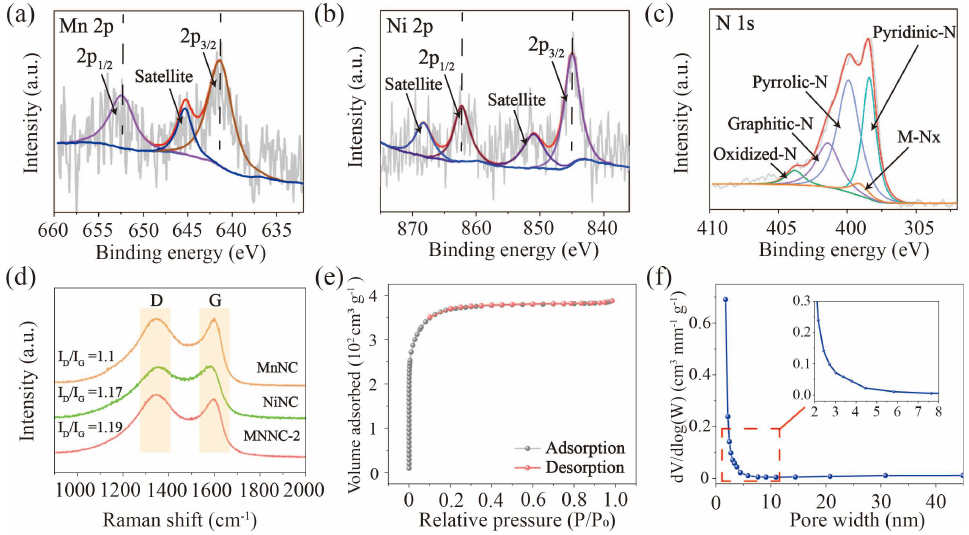
Figure 3. ( a ) Mn 2p, ( b ) Ni 2p and ( c ) N 1s XPS spectra for MNNC-2. ( d ) Raman spectra of MnNC, NiNC and MNNC-2. ( e ) N 2 adsorption–desorption isotherms and ( f ) the corresponding pore